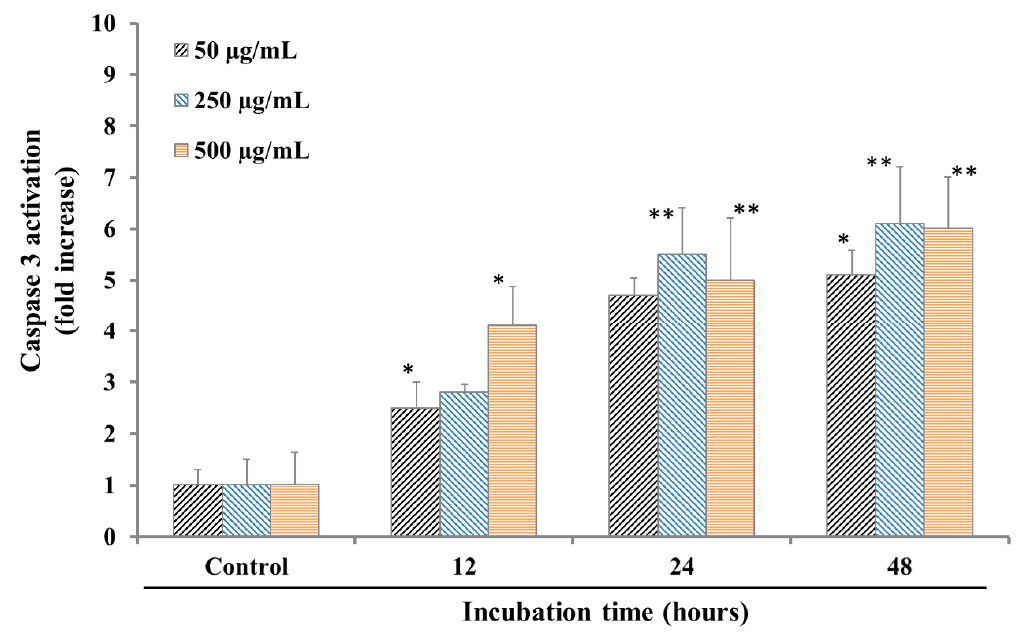
Figure 2. Effect of SPP on caspase-3 activation in HL-60 cells. HL-60 cells (1 × 10 6/ well) were